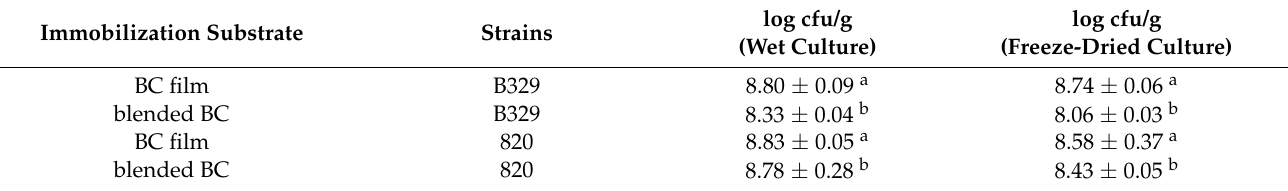
Table 1. Immobilized LAB population in different BC forms.